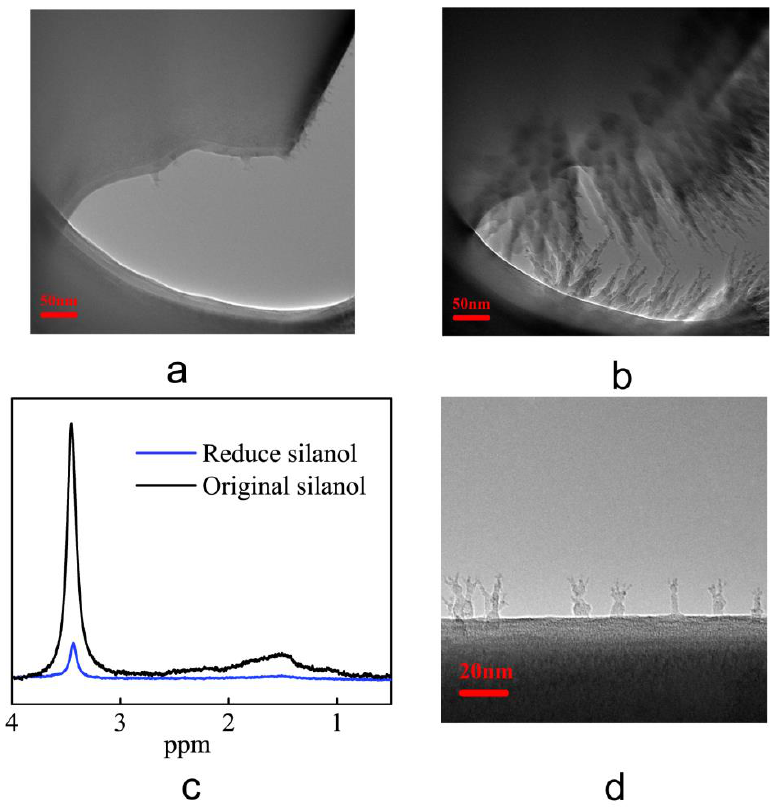
Figure 8. Effect of surface silanol content on the formation of the anomalous hexadecane. ( a , b ) The transmission electron micrographs of the samples placed for 2 weeks and 8 weeks after exposure to hexadecane. ( c ) The NMR H spectra of microtubules before and after treatment with saturated NaOH solution. ( d ) The transmission electron micrographs of the inner wall of microtubules treated with saturated NaOH solution.